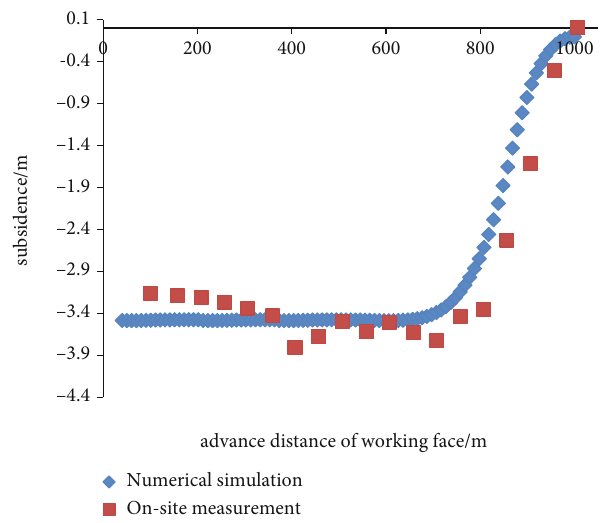
Figure 6: Comparison of surface subsidence data and simulation